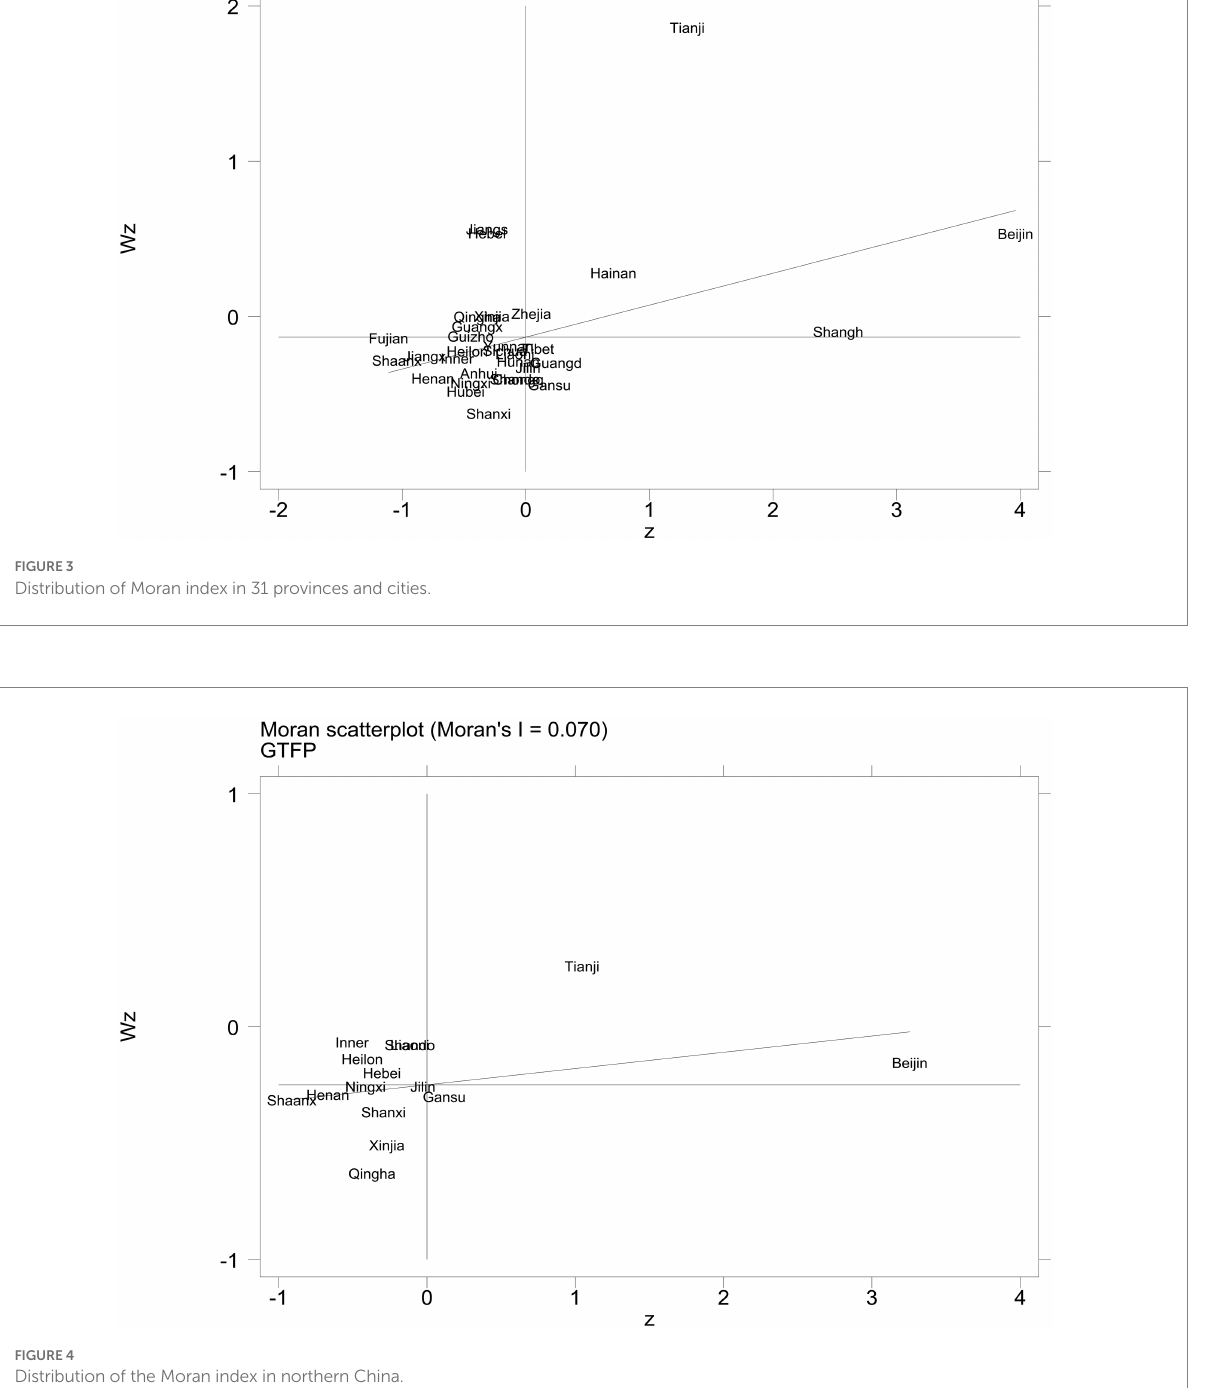
model passes the likelihood ratio test and Wald test. The results show that the LM error values are 44.32 and 59.65, respectively, and the wald test values are 40.92 and 38.15, which are significant at the 1% level. Therefore, it is more appropriate to use the spatial